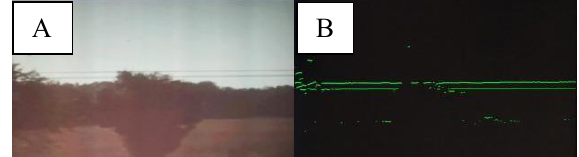
Fig. 6. Example of wire detection in the image, A – raw image from the camera, B – filtered image.